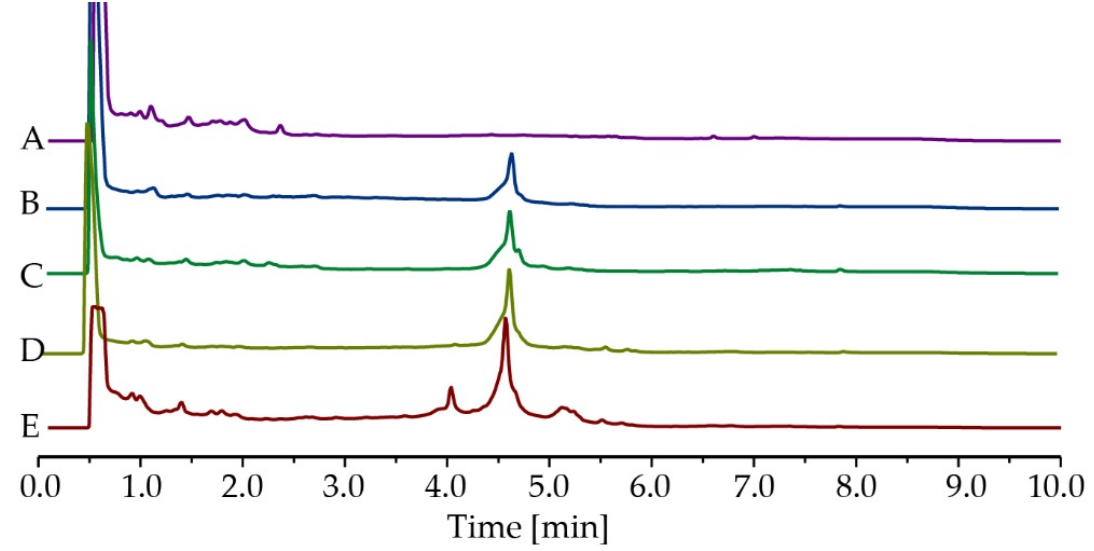
Figure 1. HPLC chromatograms of EtOAc extracts at 214 nm, ( A ) TSB, ( B ) BPR ‐ 11, ( C ) BPR ‐ 14, ( D ) BPR ‐ 16 and ( E ) BPR ‐ 17. Peaks at 0–2 min were from the culture medium TSB. Peaks at 4–6 min were metabolites produced by Bacillus .